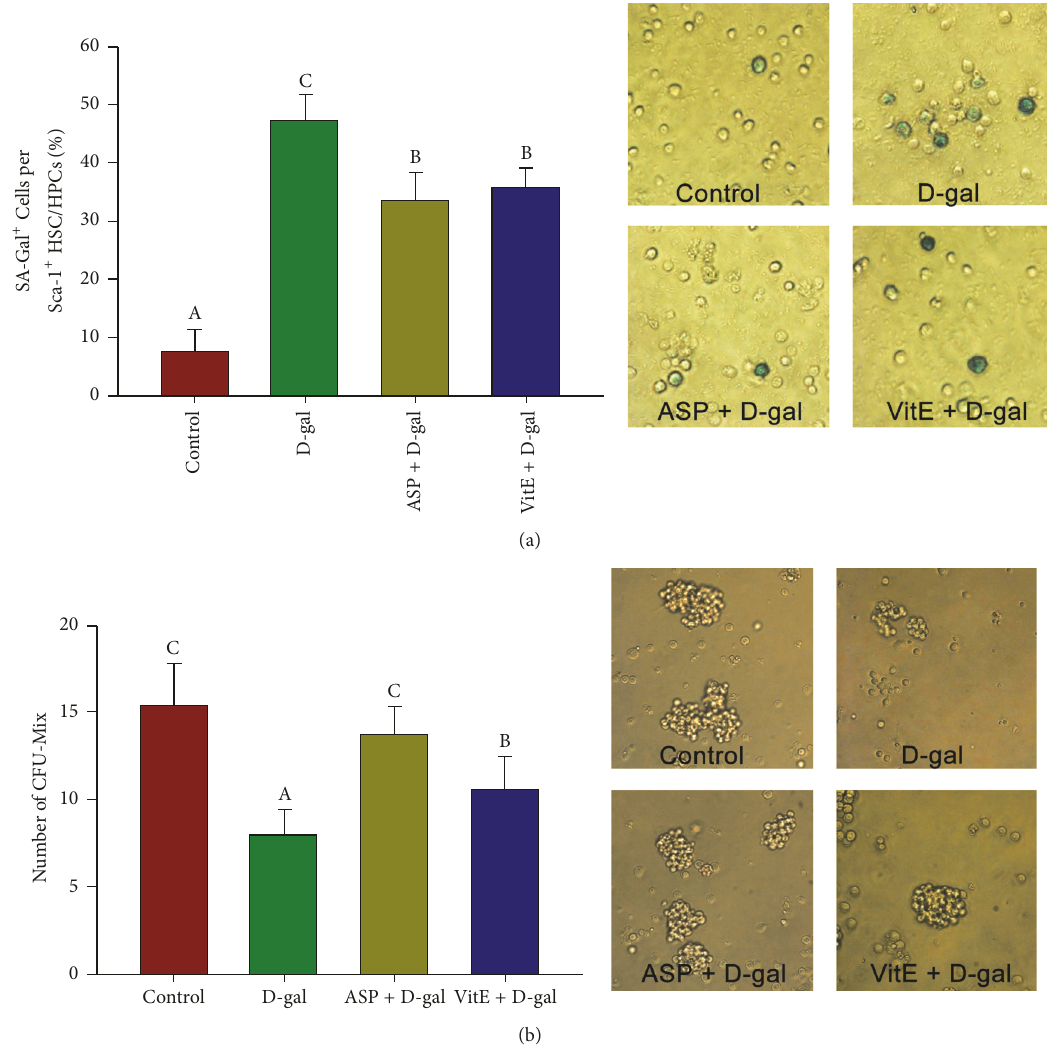
Figure 1: Effect of ASP on Sca-1 + HSC/HPCs senescence in D-gal-induced aging mice. The Sca-1+ HSC/HPCs were collected after the treatment. (a) The senescence-associated 𝛽 -galactosidase (SA- 𝛽 -gal) staining was carried out. The aged cells are stained in blue in the cytoplasm. Counting analysis of the stained cells was carried out. (b) The capacity of Sca-1+ HSC/HPCs to form hematopoietic progenitor colonies was evaluated by CFU-Mix culture. Counting analysis of the colonies was carried out. Different letters: 𝑃 < 0.05